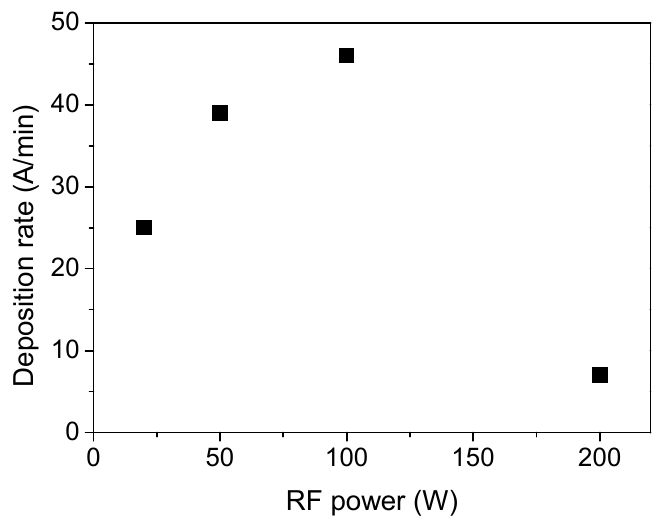
Figure 8. Film deposition rate as a function of the power delivered to the